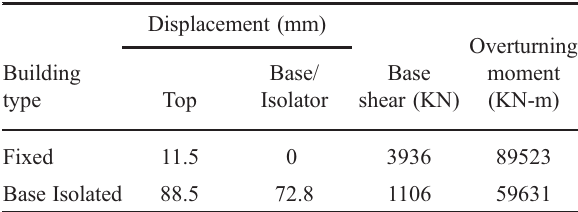
Table 10. Maximum (governing) seismic responses of fixed and base isolated structure Displacement